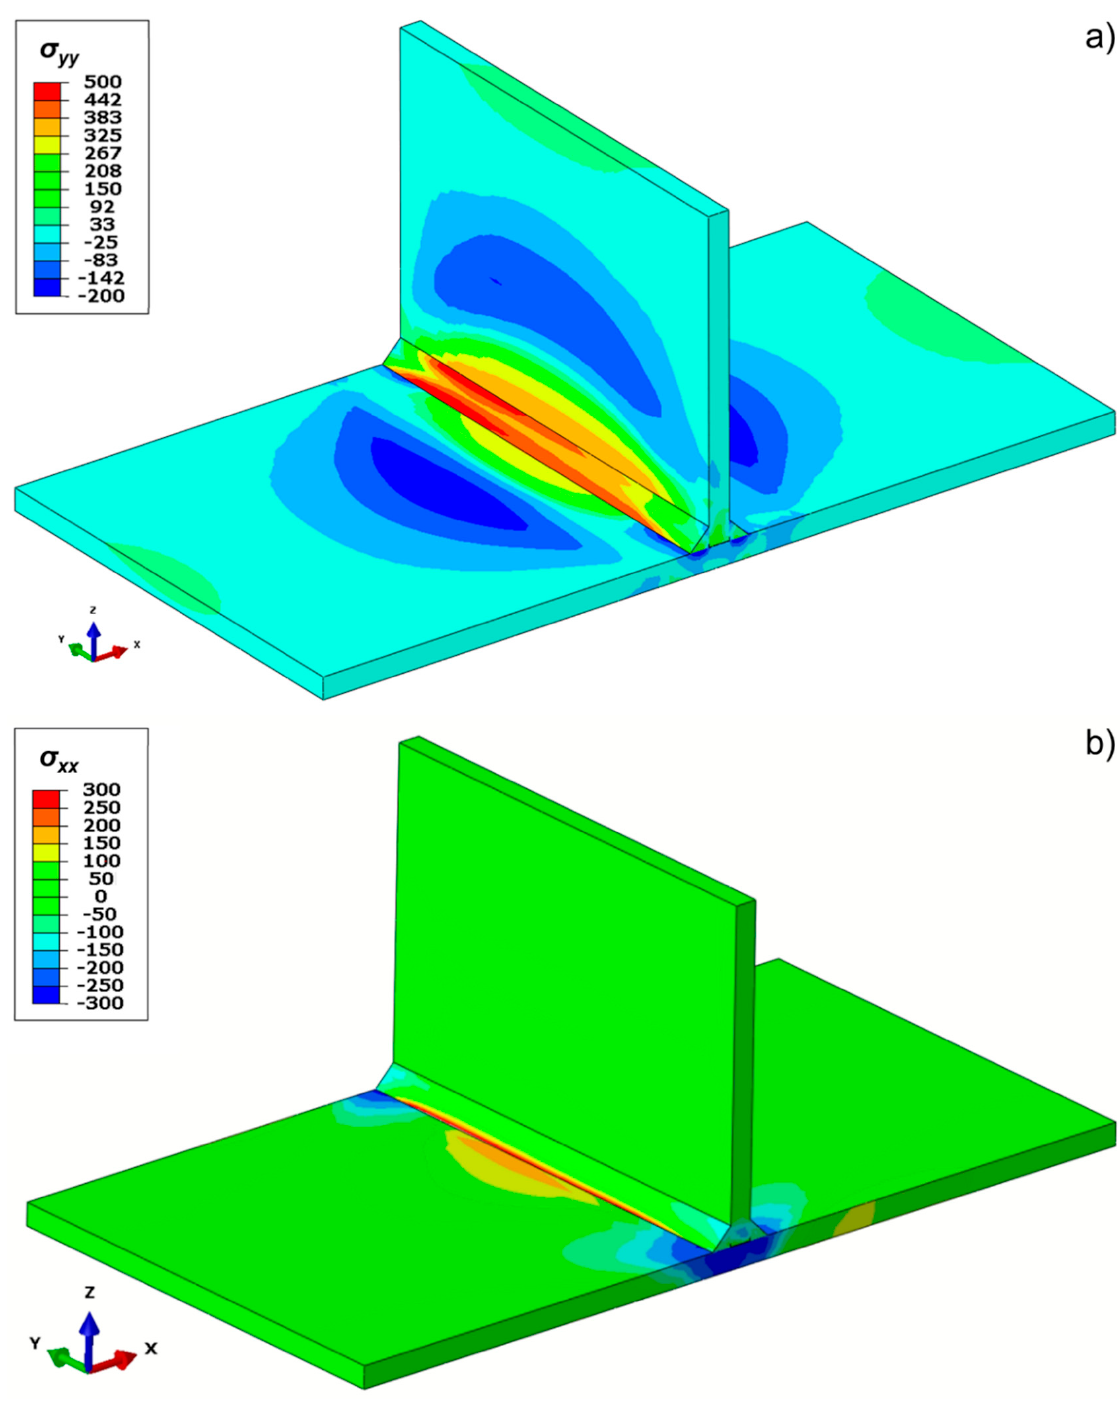
Figure 15. ( a ) Longitudinal σ yy and ( b ) transversal σ xx residual stresses [MPa] calculated numerically.